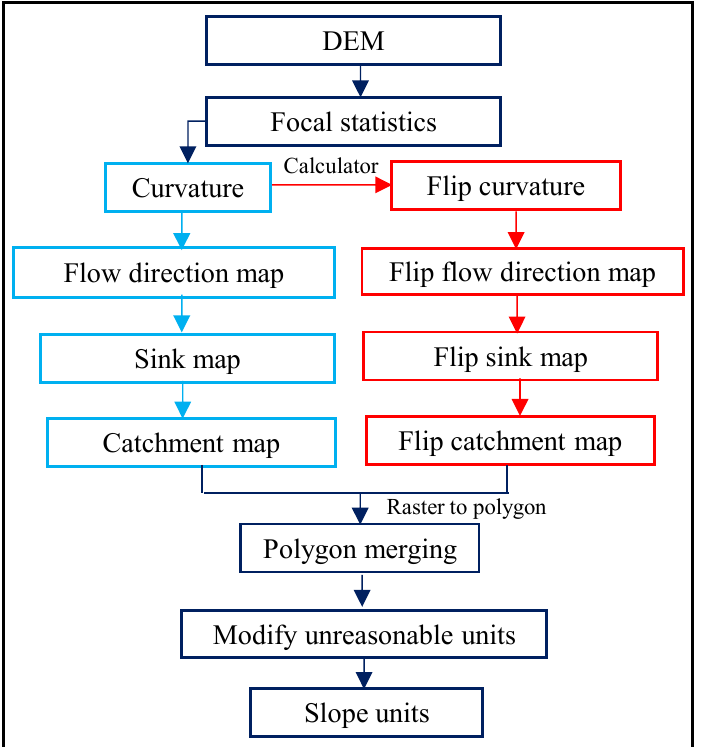
Figure 6. Slope unit division flowchart.